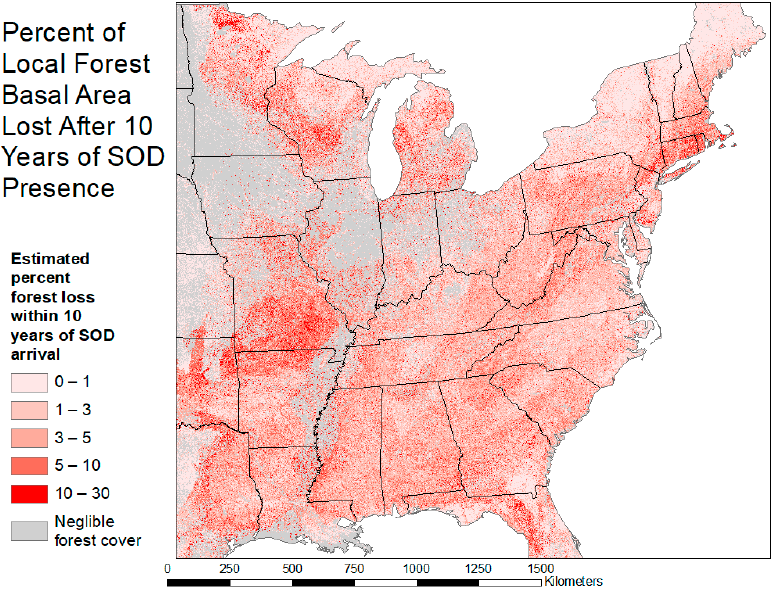
Figure 2. Estimated percentage of forest BA (assumed a proxy for canopy cover) lost within ten years of arrival of P. ramorum in the eastern USA. Resolution: 250 m. of arrival of P. ramorum in the eastern USA. Resolution: 250